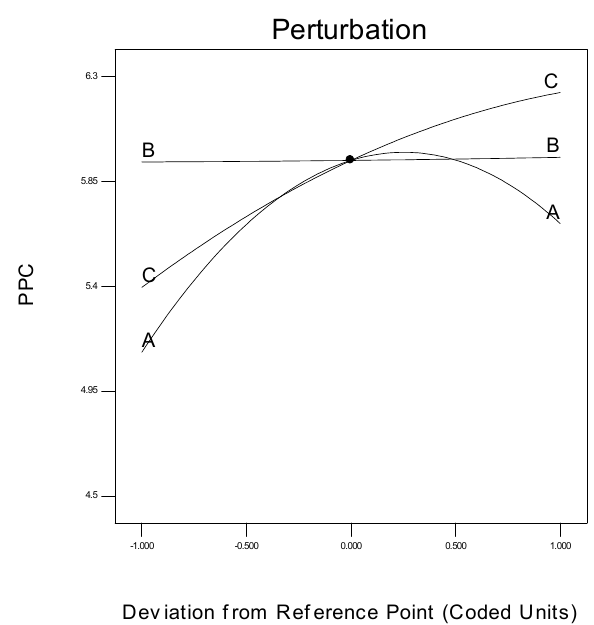
Figure 13. Deviation of individual parameter from the response.